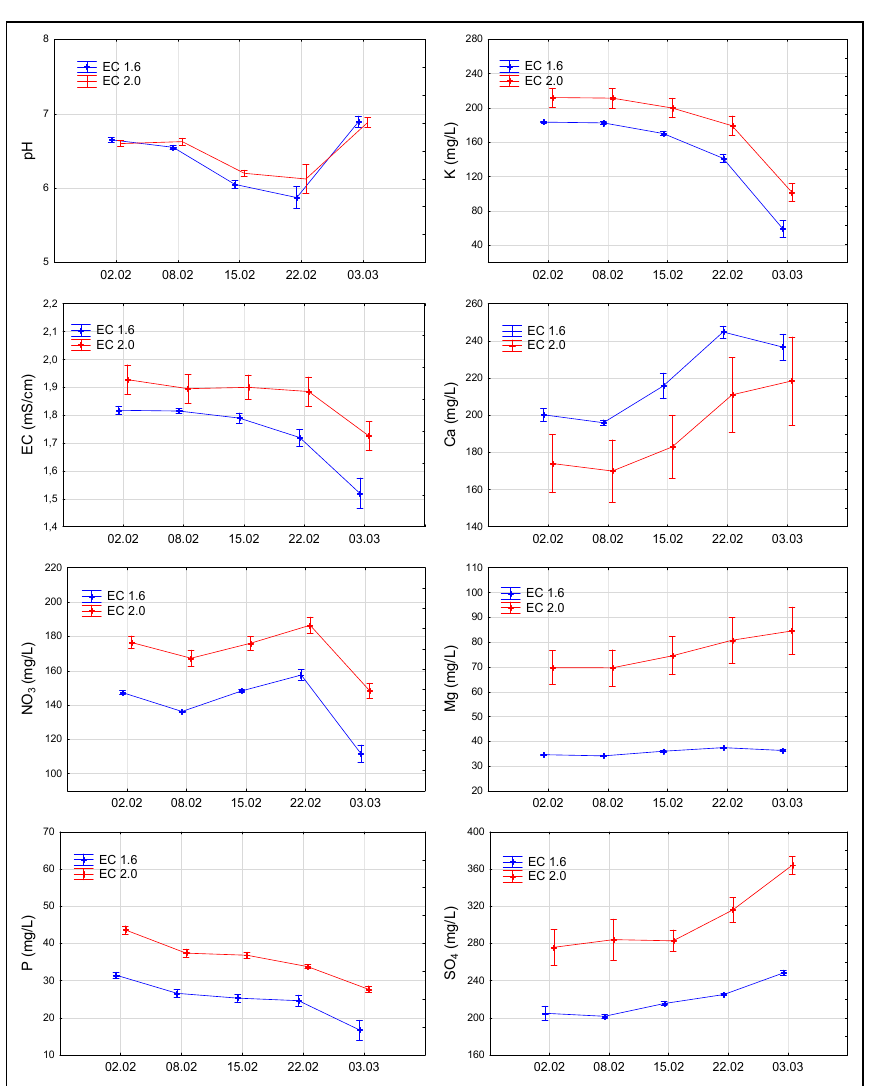
Figure 3. pH, electrical conductivity (EC), nitrate nitrogen (N-NO 3 ), phosphorus, potassium, cal- cium, magnesium, and sulfates contents in two different nutrient solutions (A and B) at weekly intervals from 25 January to 22 February 2021, for ‘Elizium’ romaine lettuce grown in a hydroponic system. Each data point is the average (±SE) for the four different light spectra (R:G:B).